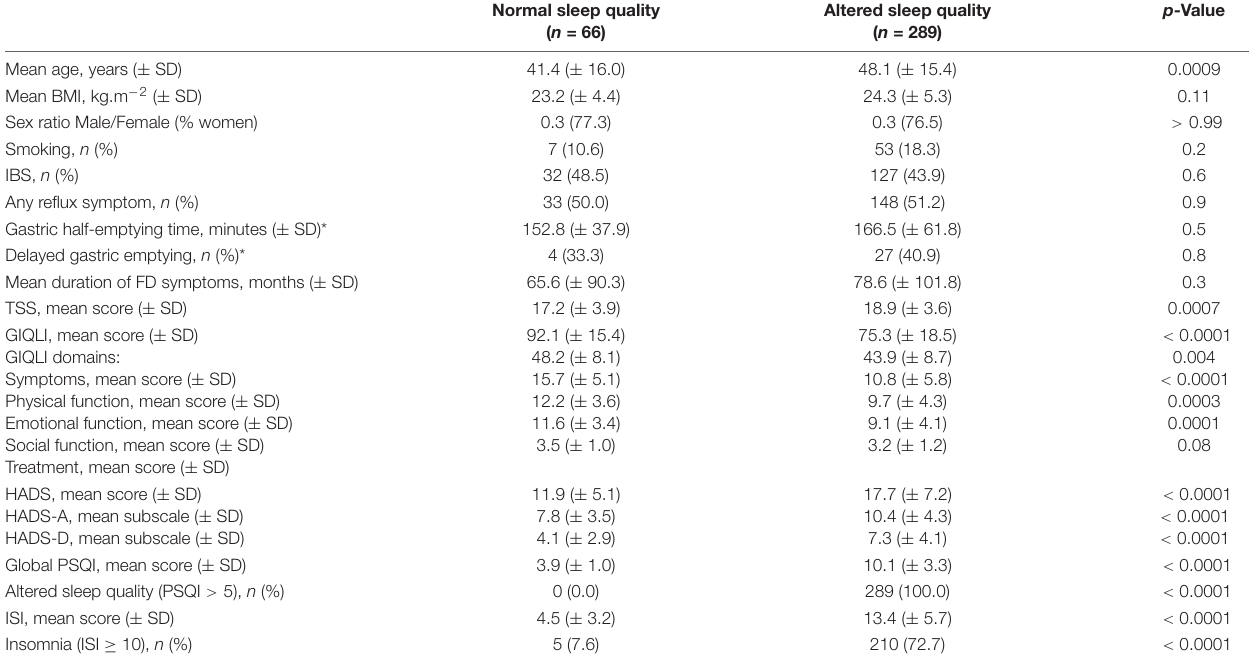
TABLE 3 | Comparison of FD patients with normal vs. altered sleep quality.